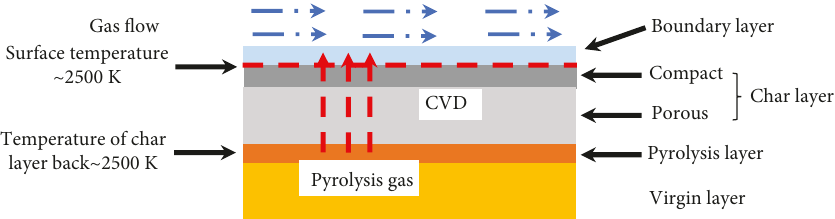
Figure 13: Schematic of the formation mechanism of the compact layer [20].